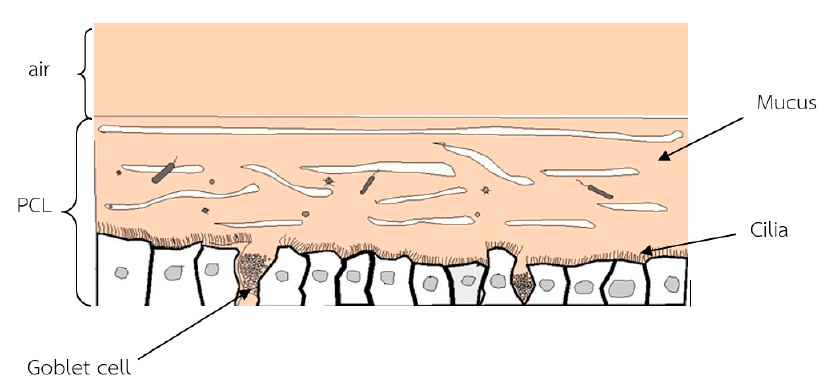
Figure 3. Platform of the innate immune system.